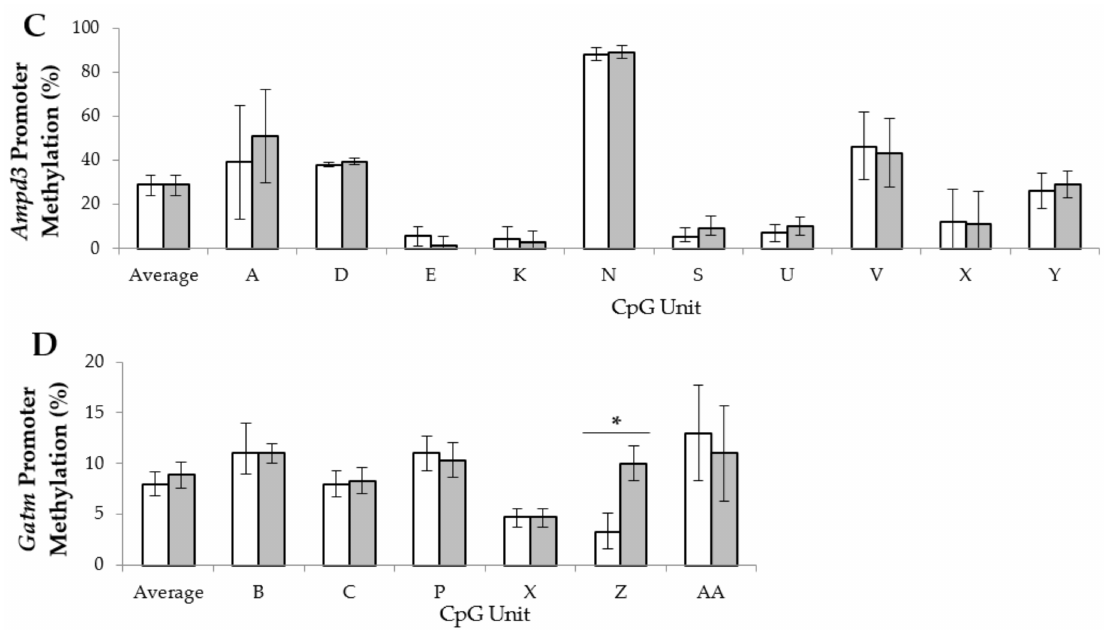
Figure 1. Average percentage of cytosine-phosphate-guanine (CpG) methylation across the promoter region and the percentage of methylation of each CpG unit within the promoter region of ( A ) Aqp1 ; ( B ) Tfpi2 ; ( C ) Ampd3 ; and ( D ) Gatm in the female placentas from dams in the 1X and 4X choline groups. Each CpG unit may contain more than one CpG site. Only CpG units with measurements that met the quality control criteria were included in the final analyses. One placenta (either male or female) from each dam ( n = 3 dams per treatment, per fetal sex) was used, and each placenta was considered to be a statistical unit in the statistical analysis. Data were analyzed using one-way ANOVA and are presented as means with 95% confidence intervals. * p ≤